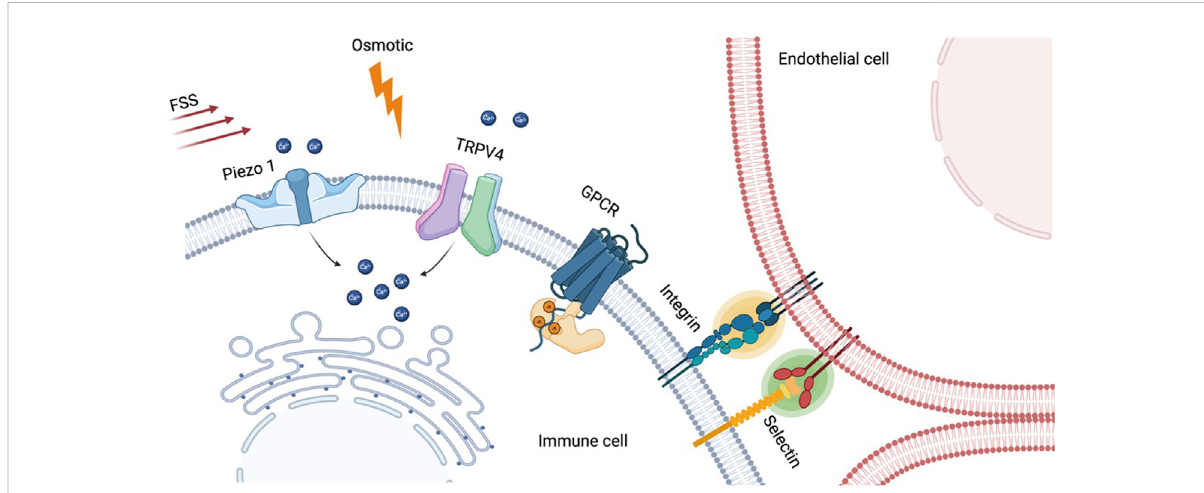
FIGURE 2 Various mechanosensitive cellular components in immune cells. Mechanically-gated ion channels such as Piezo1 and TRPV4 allow ion in fl ux (e.g.,Ca 2+ )inresponsetomembranetensiongeneratedby fl uidshearstress(FSS),osmoticshock,orligandbindingthroughadhesionmolecules.The resulting calcium elevation was found to orchestrate a broad range of immune cell functions including activation, differentiation, and polarization. Non-channel type mechanosensitive components also play role in immune cells. Cell adhesion proteins, selectin and integrin, are the well- established mechanosensors, and their bindings to endothelial cells in T cell rolling and arrest can be enhanced by laminar blood fl ow. Lastly, G protein-coupled receptors (GPCRs), a group of cellular sensors to diverse extracellular stimuli, can also be biosensors for mechanotransduction pathway in circulating immune